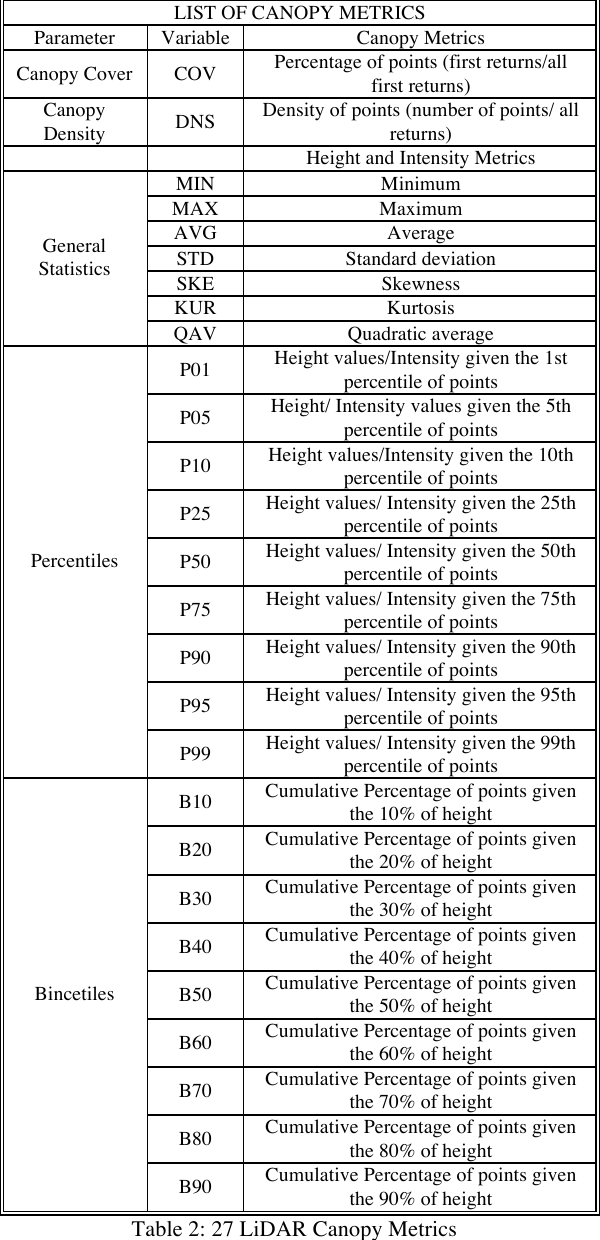
Table 2: 27 LiDAR Canopy